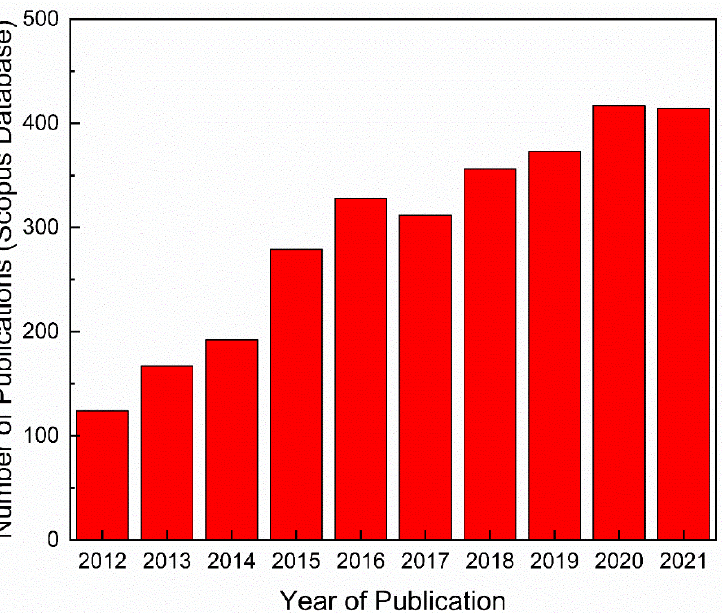
Figure 1. Number of publications related to “Forward osmosis”. Data obtained from the Scopus database (accessed on 16 July 2022).